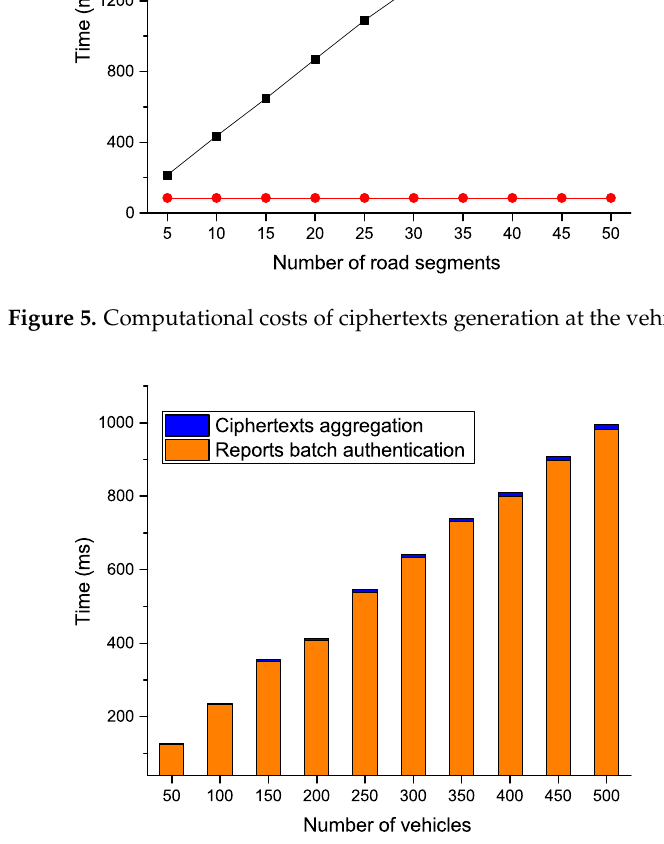
Figure 6. Computational costs of ciphertexts generation and reports batch verification at the RSU side.